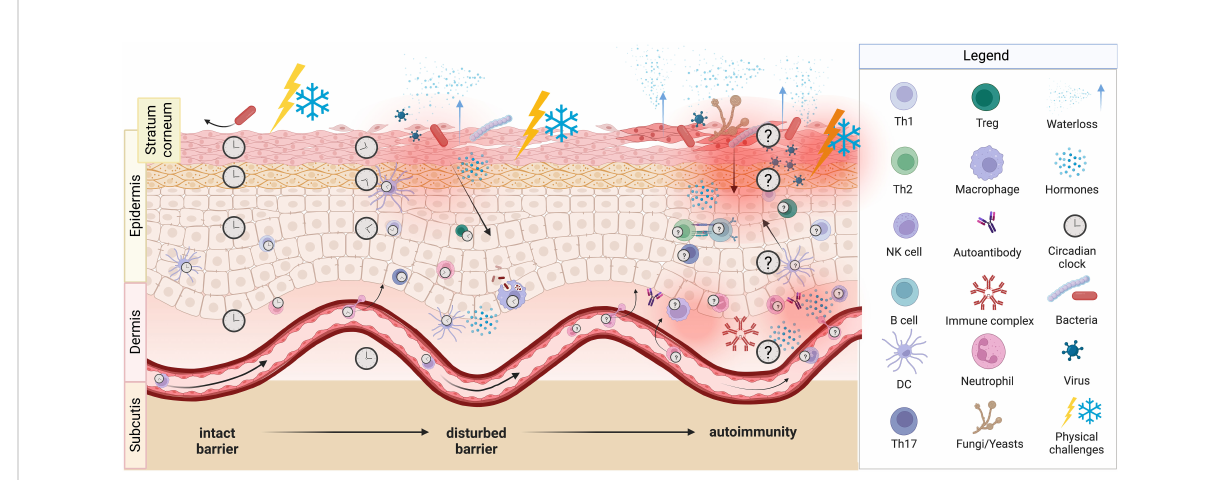
FIGURE 3 Potential consequences of shift work. Circadian misalignment and/or sleep impairments as a result of shift work presumably lead to changes in the skin barrier function. An intact barrier (left part) is able to block physical challenges as well as pathogens and prevents transepidermal water loss, whereas a disturbed barrier (middle part) is not able to do so. Noxi and intruders then can reach the epidermis, induce damage and activate immune cells and thus local in fl ammation can occur. A severely disturbed barrier (right part) shows breaches, through which bacteria, viruses and fungi enter the skin and cause in fl ammation with the attraction of various innate and adaptive immune cells. Likely, consequences are itching, scratching, and pain. Molecular clocks tick in skin cells, in innate and adaptive immune cells, as well as in endothelial cells and could be entrained by light, temperature, and neuroendocrine mediators such as cortisol, catecholamines and melatonin. We hypothesize, that this circadian system of the skin strengthens barrier functions during daytime and that shift work-induced changes favor the development of autoreactive T cells and autoantibodies resulting in autoimmune